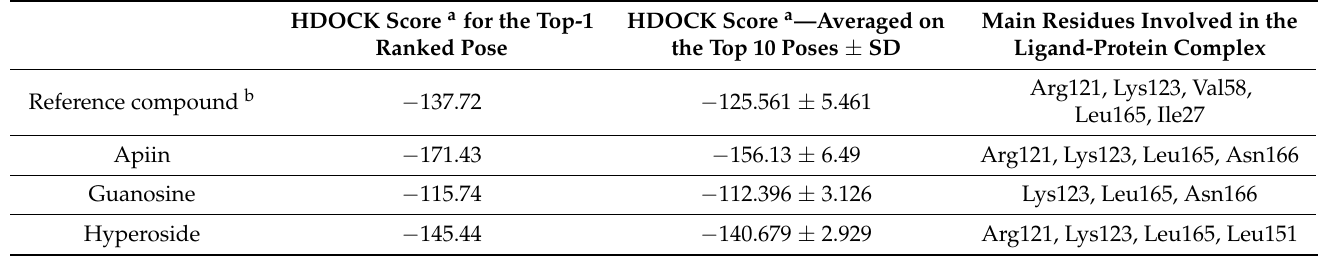
Table 3. Ligand/IL-36 complexation: HDOCK docking scores (for the top ranked poses and averaged on the Top-1–10 poses). The main amino acids involved in the ligand/protein complexes for the Reference compound and each plant metabolite are reported in the last